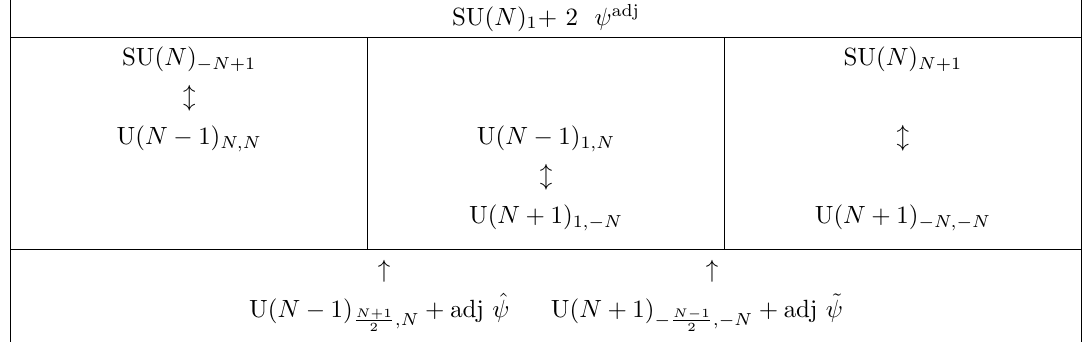
Table 1 . Phase diagram for SU( N ) 1 + 2 adj